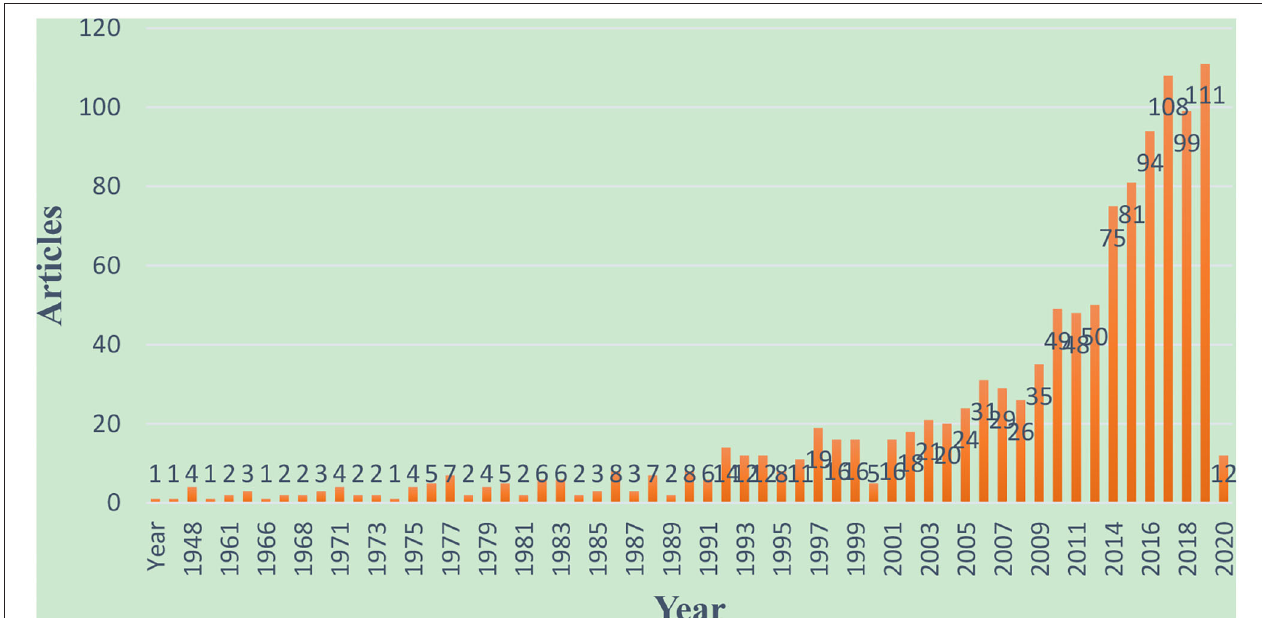
FIGURE 2 | The annual publication rate of academic procrastination research.